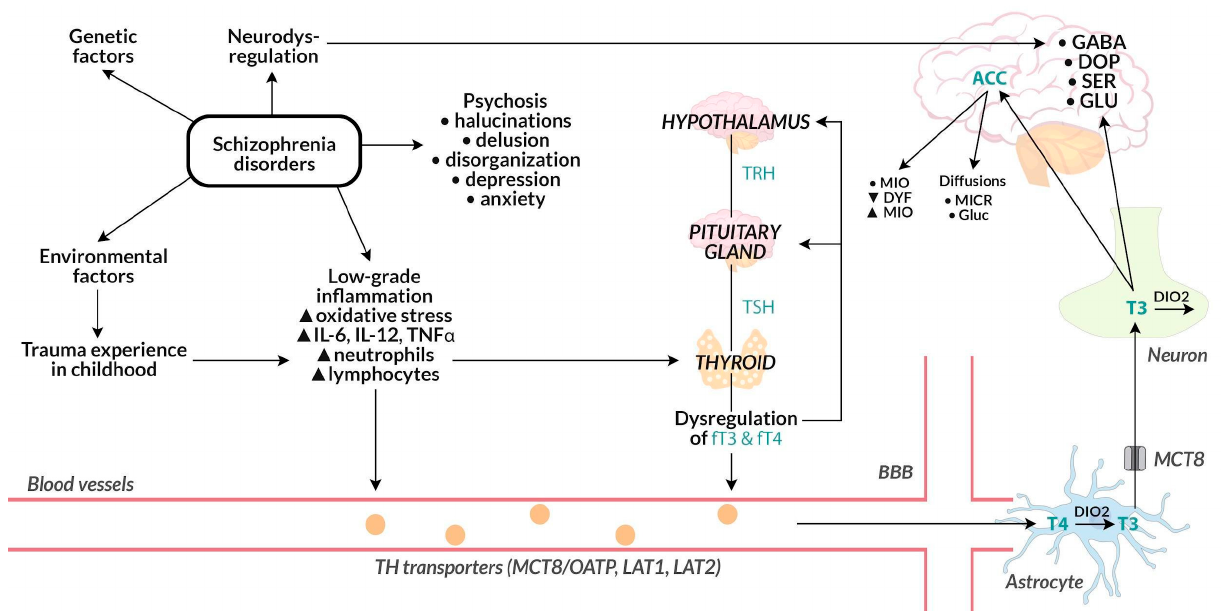
Figure 5. Relationship between schizophrenic disorders and HPT axis. DIO2—iodothyronine deiodinase 2; DOP—dopamine; DYF—diffusion; FT3—free triiodothyronine; FT4—free thyroxin;